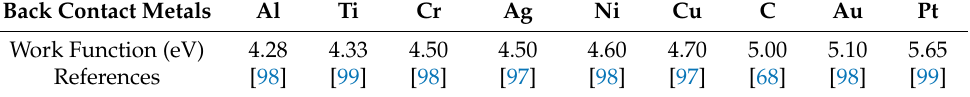
Table 2. Work function of a back contact metal.